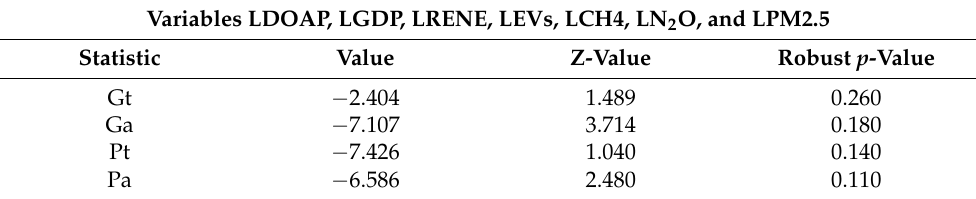
Table 8. Westerlund panel cointegration test of all variables of the